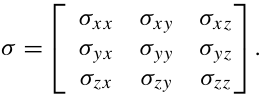
stored in the system (Garboczi, 1998). Figure 8a and b